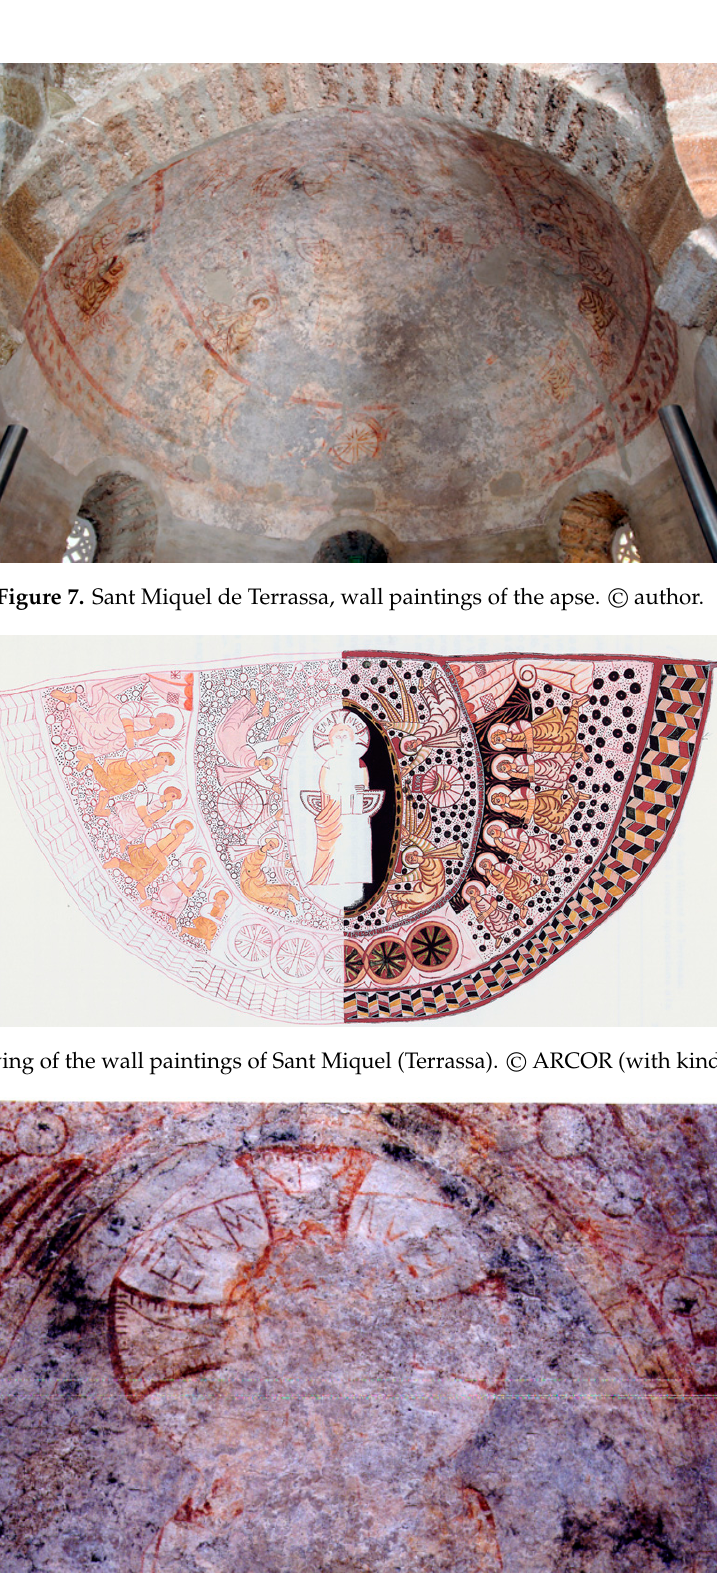
Figure 10. Sant Miquel de Terrassa, wall paintings. Image of the moon. © ARCOR. The lower area is occupied by the apostles presented in profile, kneeling and wearing clothing that is clearly of a Roman tradition: a tunic, a praetexta toga, and sandals. In the central dividing band several tituli with the names of six apostles appear: Petrus, Andreas, Iacobus, Iohannes, Philippus, and Bartholomeus (Peter, Andrew, James, John, Philip, and Bartholomew). In the central part of this band, coinciding with the five circles of the lower register, there are lines that correspond to decorative motifs and next, there is another large band that would hold the inscriptions of six more apostles, which have disappeared. In the extreme right, we can only identify an “S”, followed by a cross which we should relate to Paulus (the Apostle Paul) . Finally, in the space located between the two groups of apostles, five circles with concentric lines are represented. The central one has eight spokes and probably would be interpreted as being a Crismon, while the remaining four allude to, as we shall see, the wheels of the vision of Ezekiel. 4.1. A Synoptic Theophany Identification of the iconographic theme represented in the apse of Sant Miquel has been the subject of debate among scholars who have dwelt on the paintings. Puig i Cadafalch (1936) interpreted the scene as a theophany derived from the second vision of Ezekiel and identified the 12 characters from the lower register as being “people of varying social conditions of Jerusalem”. On the other hand, Charles Kuhn defined the iconography as a combination of an apocalyptic vision and that of Ezekiel, converting the Apostles into the Elders of the Apocalypse, reduced from 25 to 12 (Kuhn 1928, 1930, pp. 9–11). However, the epigraphic study undertaken by the team of the ICAC and the Universitat Rovira i Virgili in 2015 has allowed us to read the didactic character inscriptions that appear together with the figures in the lower register (López Vilar and Gorostidi 2015a), a fact that allows us unequivocally identify the figures as the Apostles (Figure 11).